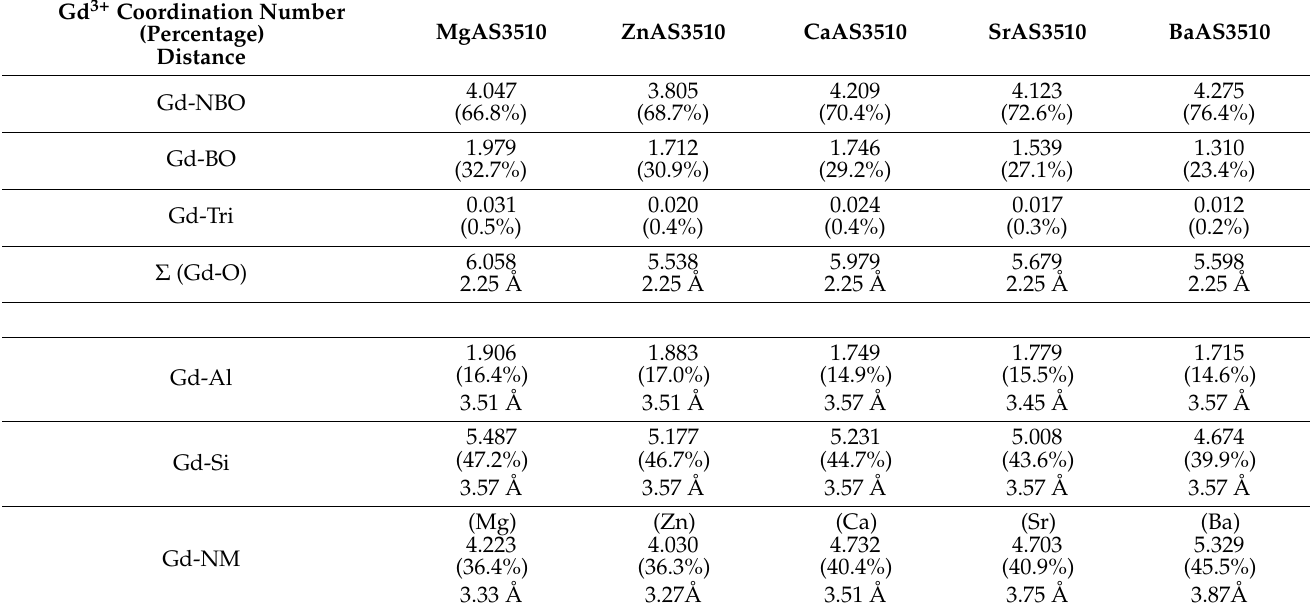
Figure 2. Molecular dynamic simulation results. Left picture: An inherent structure of 413 atoms of the glass composition CaAS3510 as obtained by the MD simulations. Right picture: A slice of the CaAS3510 composition showing its structure in more detail. SiO 4 tetrahedra (yellow) and [AlO 4 ] − tetrahedra (gray) interconnected by bridging oxygen (BO, red) form the three-dimensional glass network. The network modifying ions Ca 2+ (light blue) and Gd 3+ (pink) interrupt the network and form depolymerized regions. Their charge is compensated by non-bridging oxygen (NBO, blue) and [AlO 4 ] − . Note that the structure extends behind and in front of this slice. Table 2. Gd 3+ coordination according to molecular dynamic simulations. Upper part of the table: the coordination numbers (CN) of Gd 3+ with different oxygen species in the first coordination sphere in the investigated glasses and the percentages of the different oxygen coordinations. The Gd-O distances are constant at 2.25 Å. NBO: non-bridging oxygen, BO: bridging oxygen, Tri: oxygen triclusters. Lower part: the coordination numbers (CN) of Gd 3+ with different cations Al 3+ , Si 4+ , Mg 2+ , Zn 2+ , Ca 2+ , Sr 2+ , Ba 2+ in the second coordination sphere, the percentages of the different coordinations and the distance between Gd 3+ and the respective